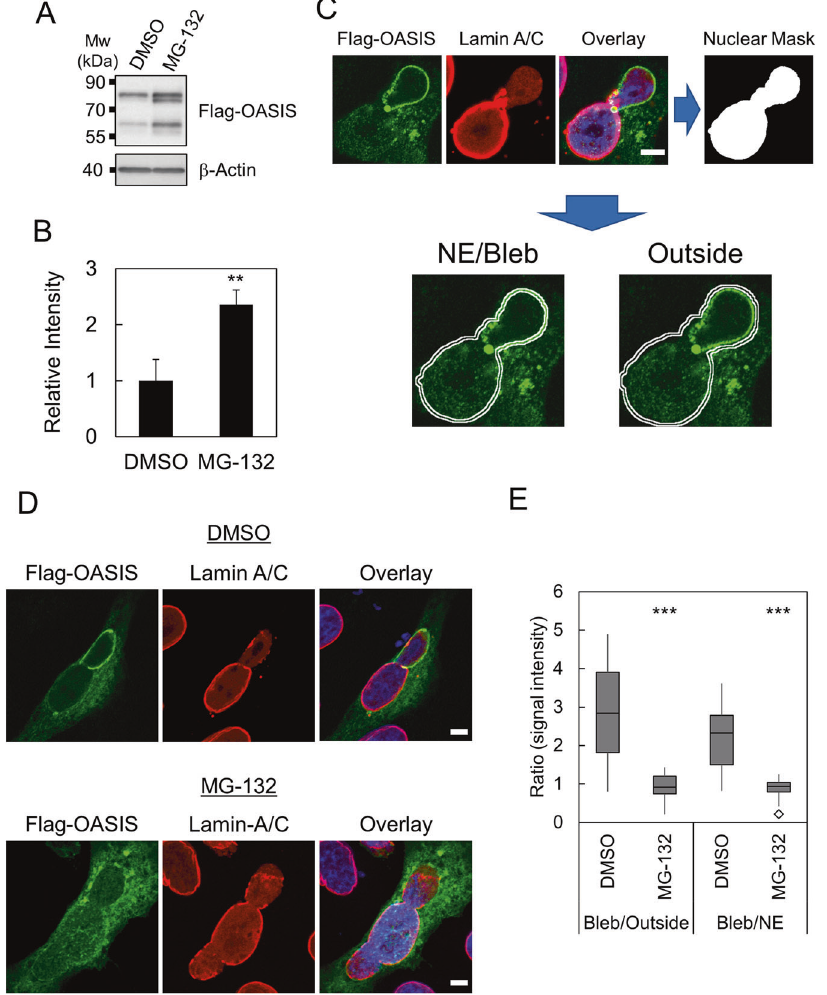
Fig. 3 Inhibition of proteasome-dependent degradation attenuates the accumulation of OASIS at the damaged NE. A Western blotting analysis of shLMNB1 cells expressing Flag-OASIS treated with DMSO or MG-132. β -Actin was used as a loading control. B Quanti fi cation of relative protein levels in ( A ). Bars and error bars represent the mean values and SD from three independent experiments, respectively. The statistical signi fi cance of differences was determined using Student ’ s t -test. ** p < 0.01. C Schematic representation of quanti fi cation of Flag- OASIS signal at the intact NE of main nuclei (NE), damaged NE of nuclear blebs (Bleb), and outside of these regions (Outside). Nuclear mask was generated using the signal of immuno fl uorescence staining of Lamin A/C. Note that Bleb is de fi ned by chromatin herniation and partial or complete loss of Lamin A at the rim and that NE does not include the nuclear bleb for the quanti fi cation. D Immuno fl uorescence staining analysis of Flag-OASIS-expressing shLMNB1 cells treated with DMSO (upper panels) and MG-132 (lower panels). E Quanti fi cation of the ratio of signal intensity of Bleb to NE and Bleb to outside in single cell. Box plot represents the medians and interquartile ranges with Tukey-style whiskers. Statistical signi fi cance of the differences was determined using Mann – Whitney ’ s U -test. *** p < 0.005. n = 13 DMSO and n = 14 MG- 132 from two independent experiments. Scale bars: 5 μ